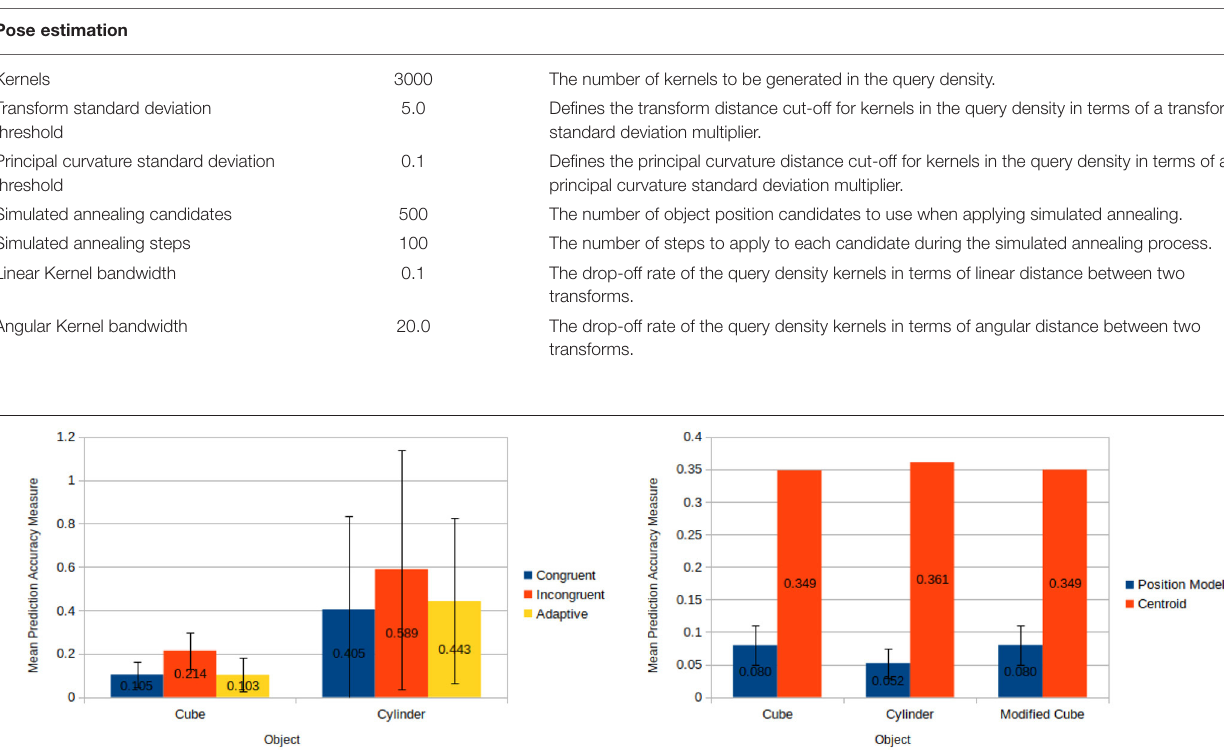
TABLE 3 | Experimental parameters for the experiments on pose estimation (section 8.2).